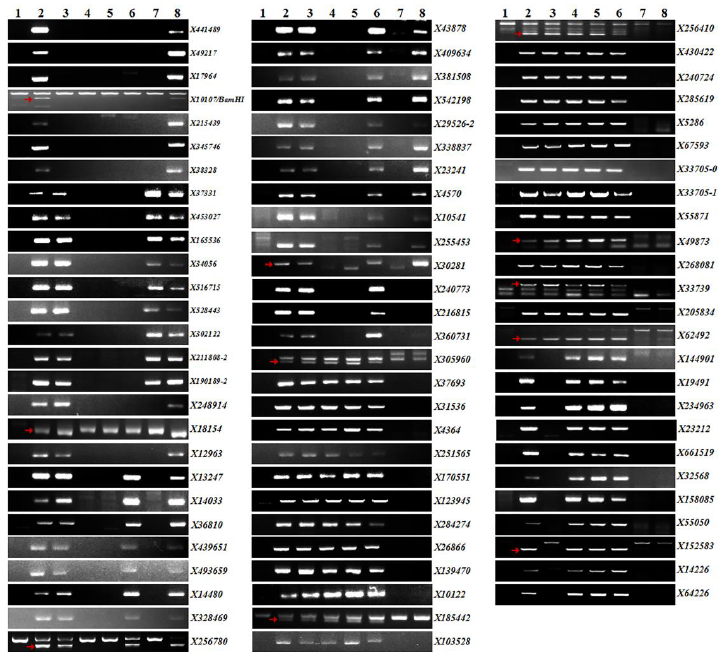
Figure 3. Electrophoresis patterns of 79 2S s #1-specific molecular markers identified in this study. Lanes: 1, CS; 2, CS- Ae . searsii 2S s #1 disomic addition line (2011-400); 3-6, CS- Ae . searsii 2S s #1 recombinant 89-88, 89-69, 89–346, and 89–185, which carried Pm57 , respectively; 7–8, CS- Ae . searsii 2S s #1 recombinants 89–152 and 89–378 with no Pm57 genes. The arrows indicate PCR amplification bands of 2S s #1 specificity while more than a band amplified.